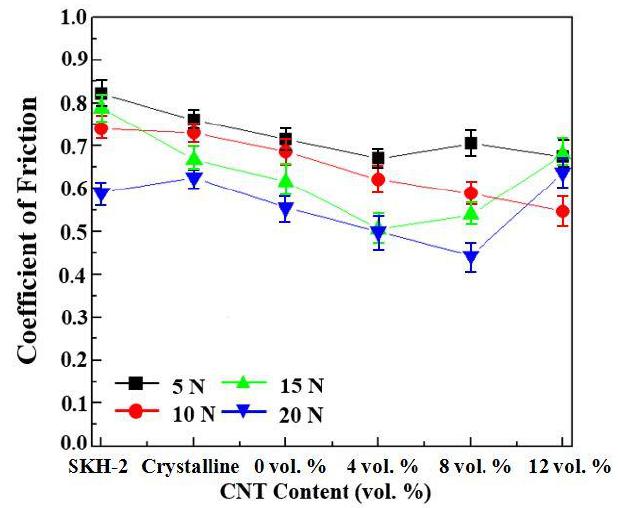
Figure 7. Effects of CNT volume fraction on the friction coefficients of Ti 50 Cu 28 Ni 15 Sn 7 BMG composites under different loads.